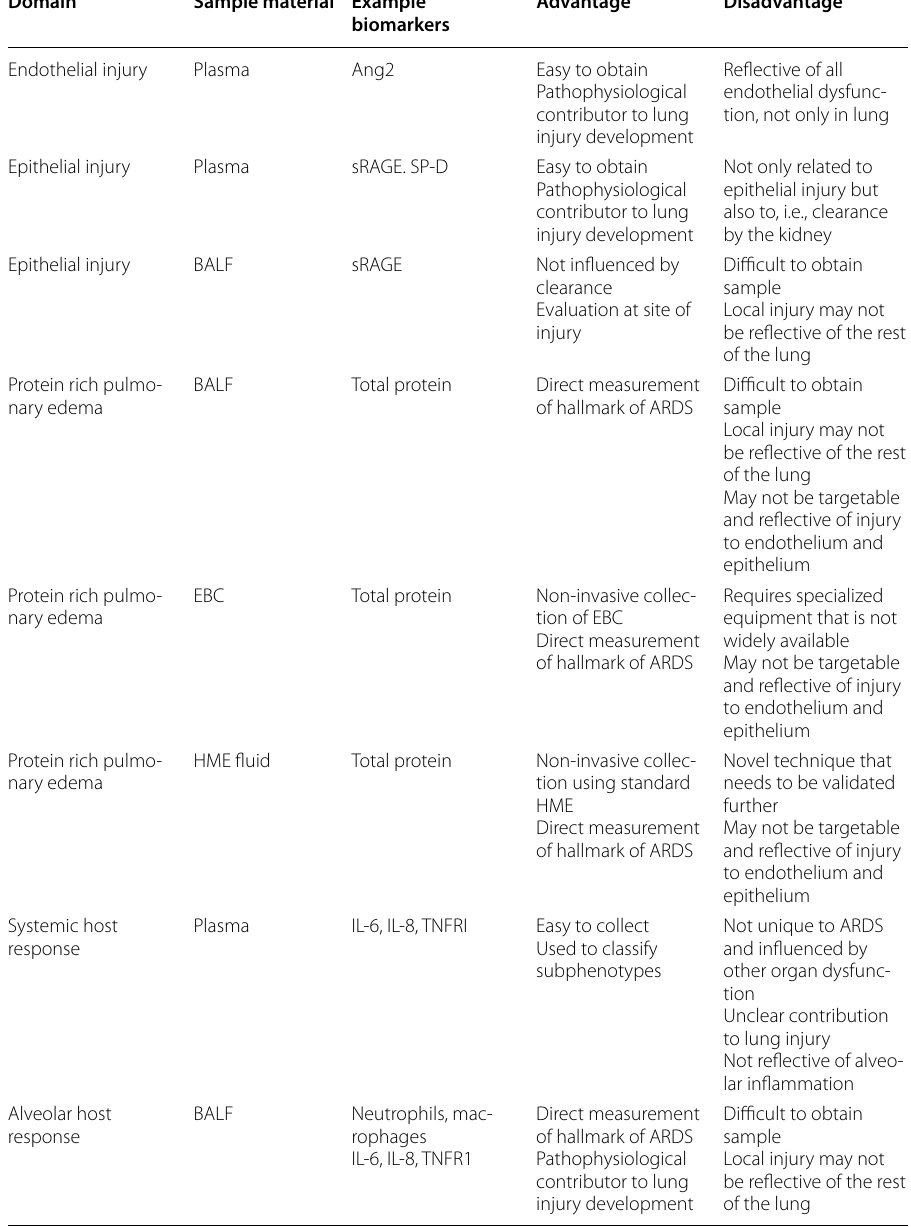
Table 2 Summary of biological